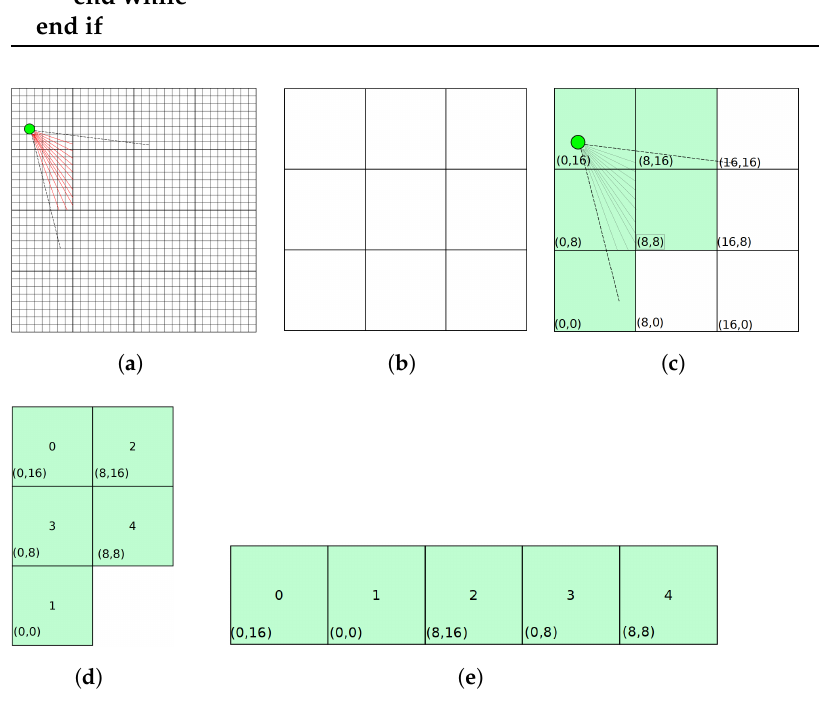
Figure 1. Node level ray-casting. Used to determine the nodes within the potential view-space of the sensor that are traversed by the rays defined by the input point cloud. ( a ) Agent receives point cloud data. ( b ) Potential area of new information according to known sensor properties. ( c ) Active nodes detected via ray-casting. ( d ) Each active node assigned a unique index. ( e ) Leaf Index array populated with active leaf node